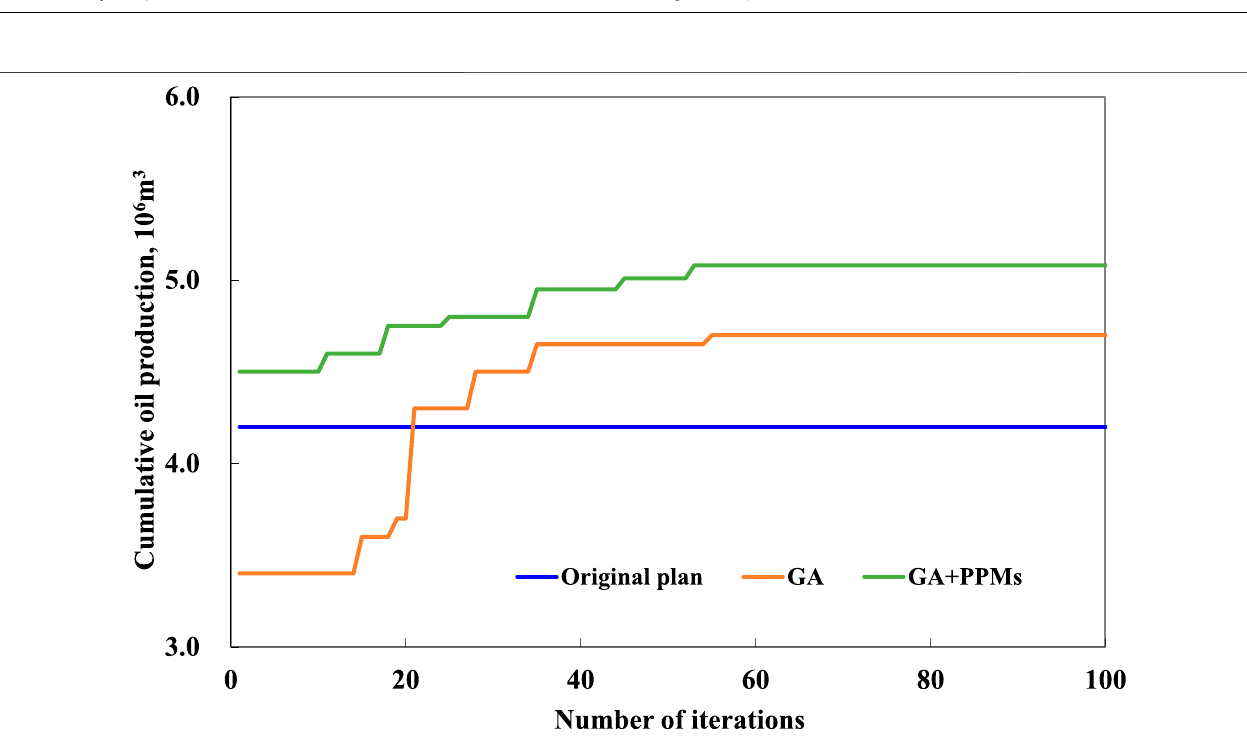
FIGURE 8 | Curve of the cumulative oil production changing with the number of iterations proposed by GA + PPMs, GA, and original plan.